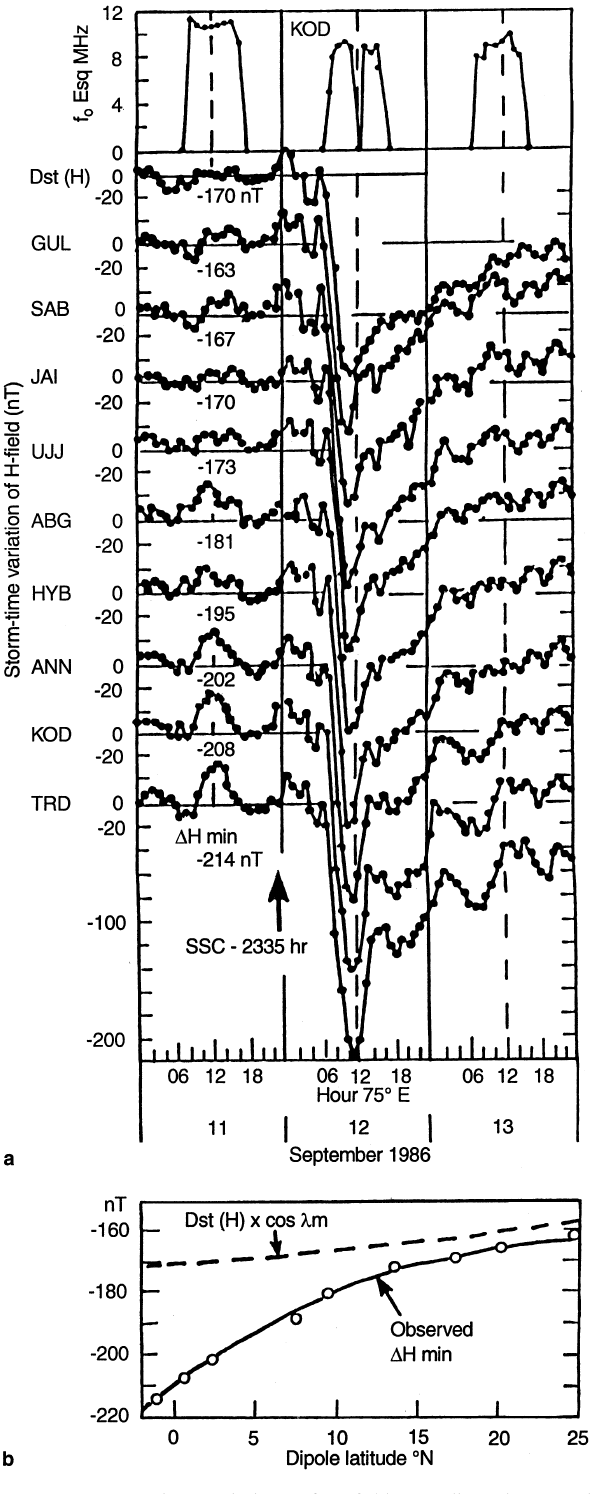
Fig. 2. a Storm time variations of H field at Indian observatories during the storm starting at 2335 hours 75 (cid:176) EMT on 11 Sep. 1986. b Latitudinal variations of the observed minimum of H at di(cid:128)erent stations during the peak disturbance activity compared with the latitudinal variation of Dst(H) index · cosine